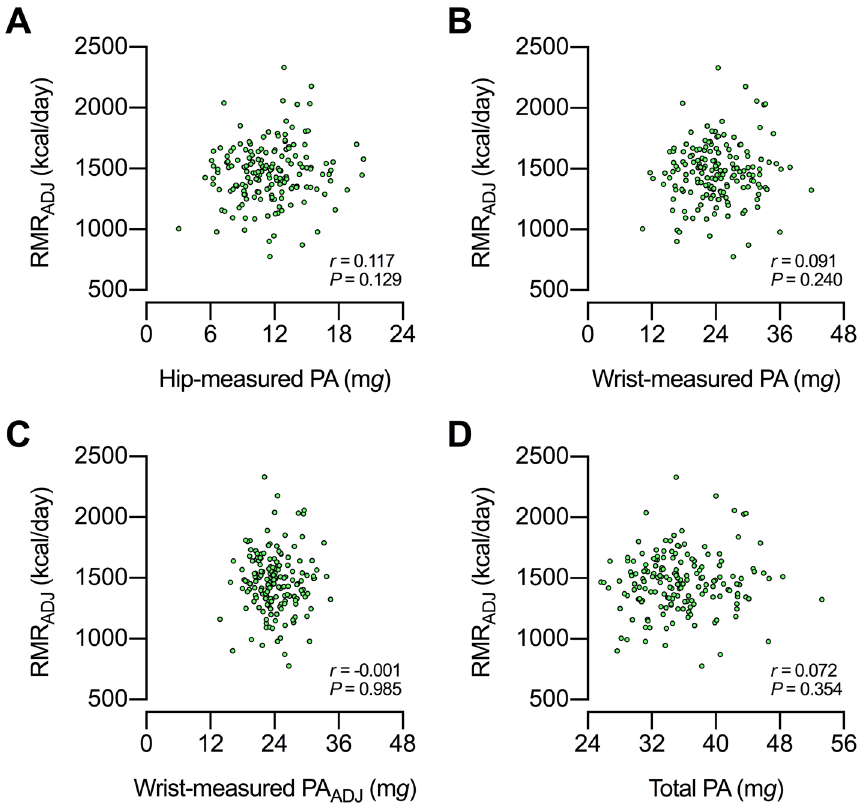
Figure 4. Association between resting metabolic rate [RMR] and physical activity [PA] in adults. RMR adjusted for lean mass [RMR ADJ ] was associated with ( A ) hip-measured PA, ( B ) wrist-measured PA, ( C ) wrist-measured PA adjusted for hip-measured PA [wrist-measured PA ADJ ], or ( D ) total PA [hip-measured PA plus wrist- measured PA ADJ ]. n =